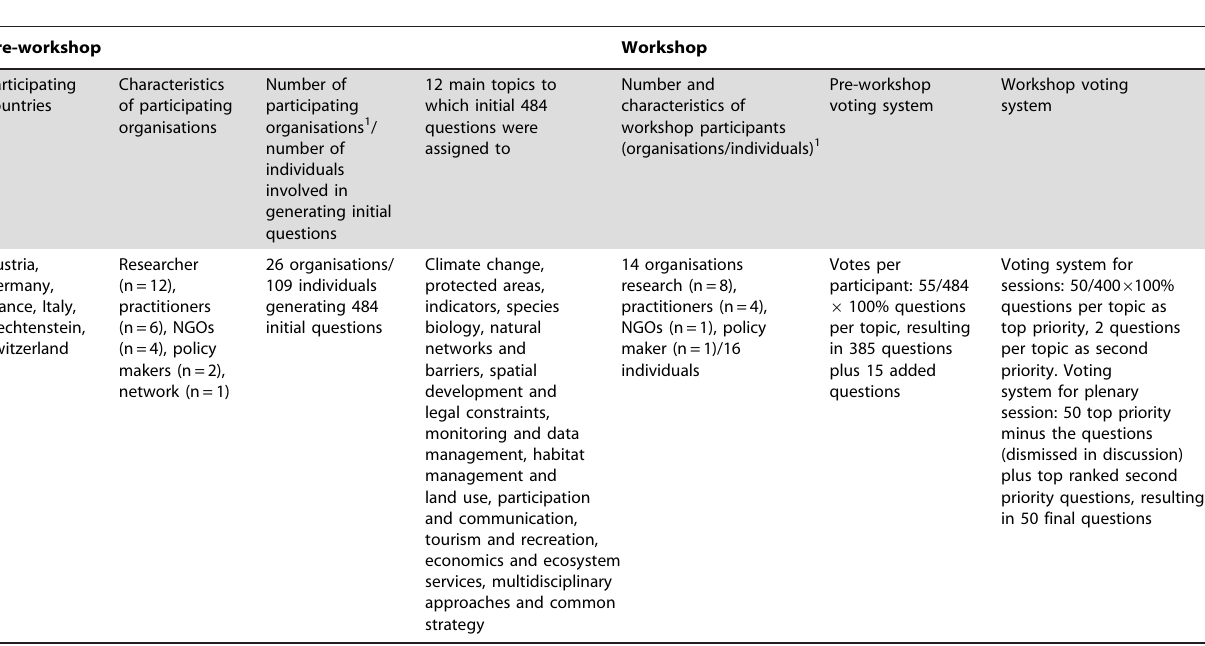
Table 3. Characteristics and voting systems of the priority setting